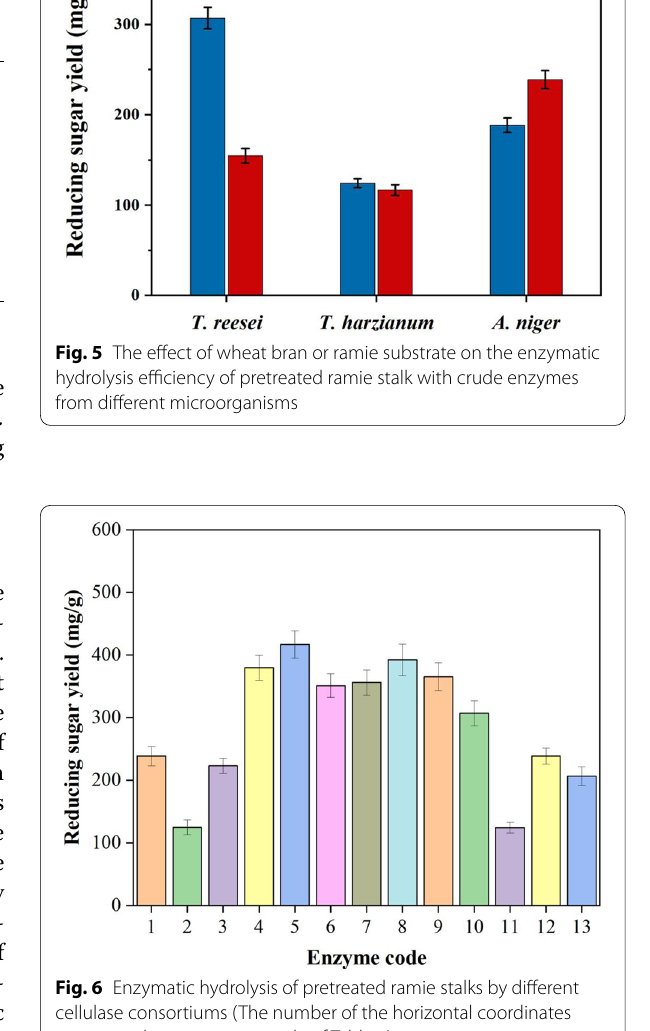
Table 2 The optimized culture condition(temperature, pH and culture time) of A. niger , T. harzianum and T. reesei and their corresponding enzyme activity(CMCase, FPA and β-glucosidase) Aspergillus niger